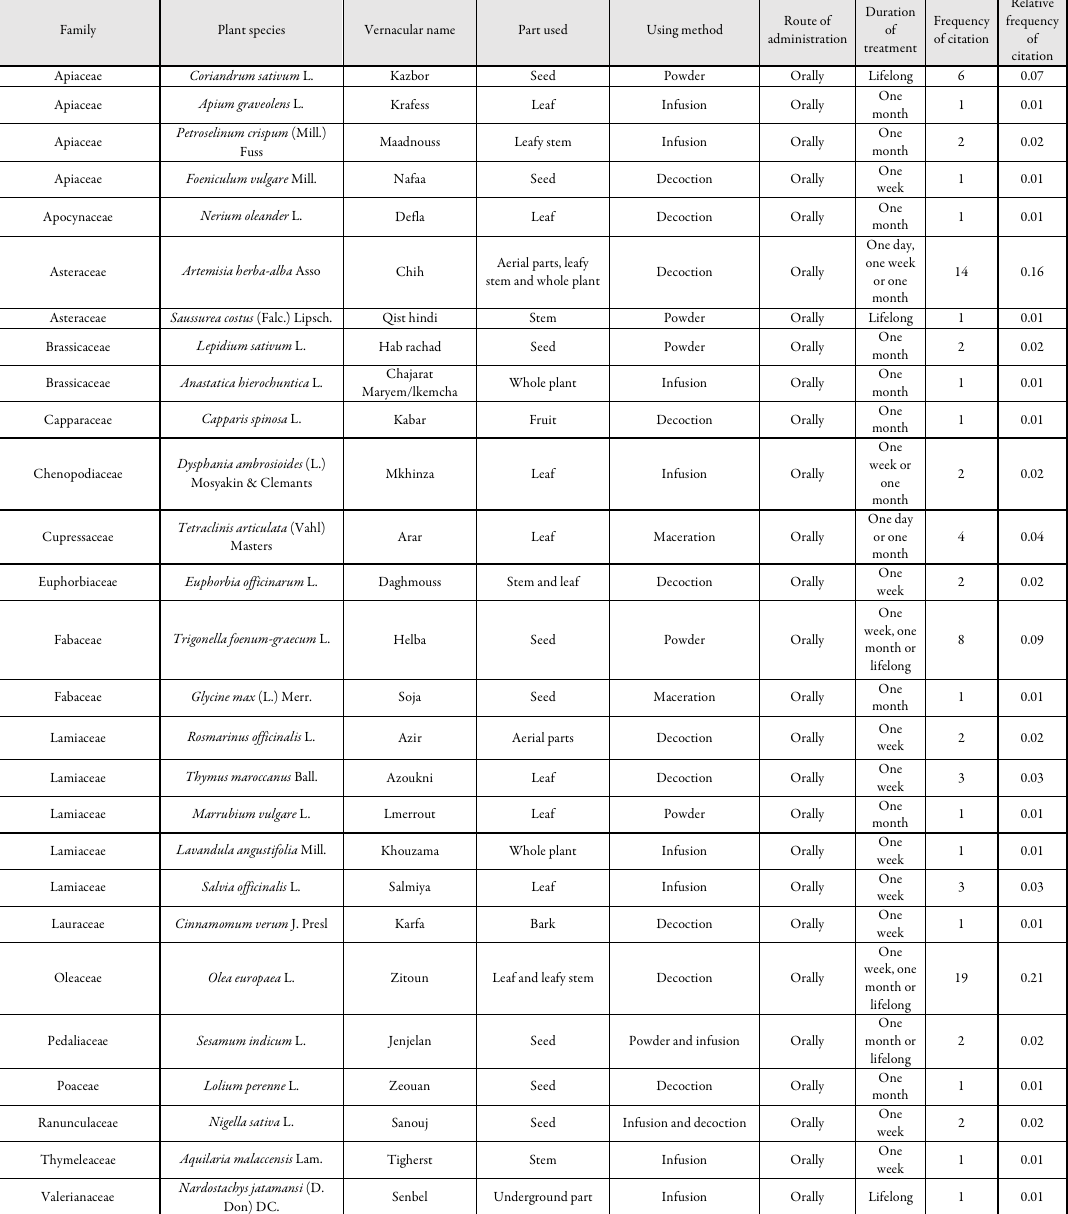
Table 4. Ethnobotanical remedies for the treatment of diabetes